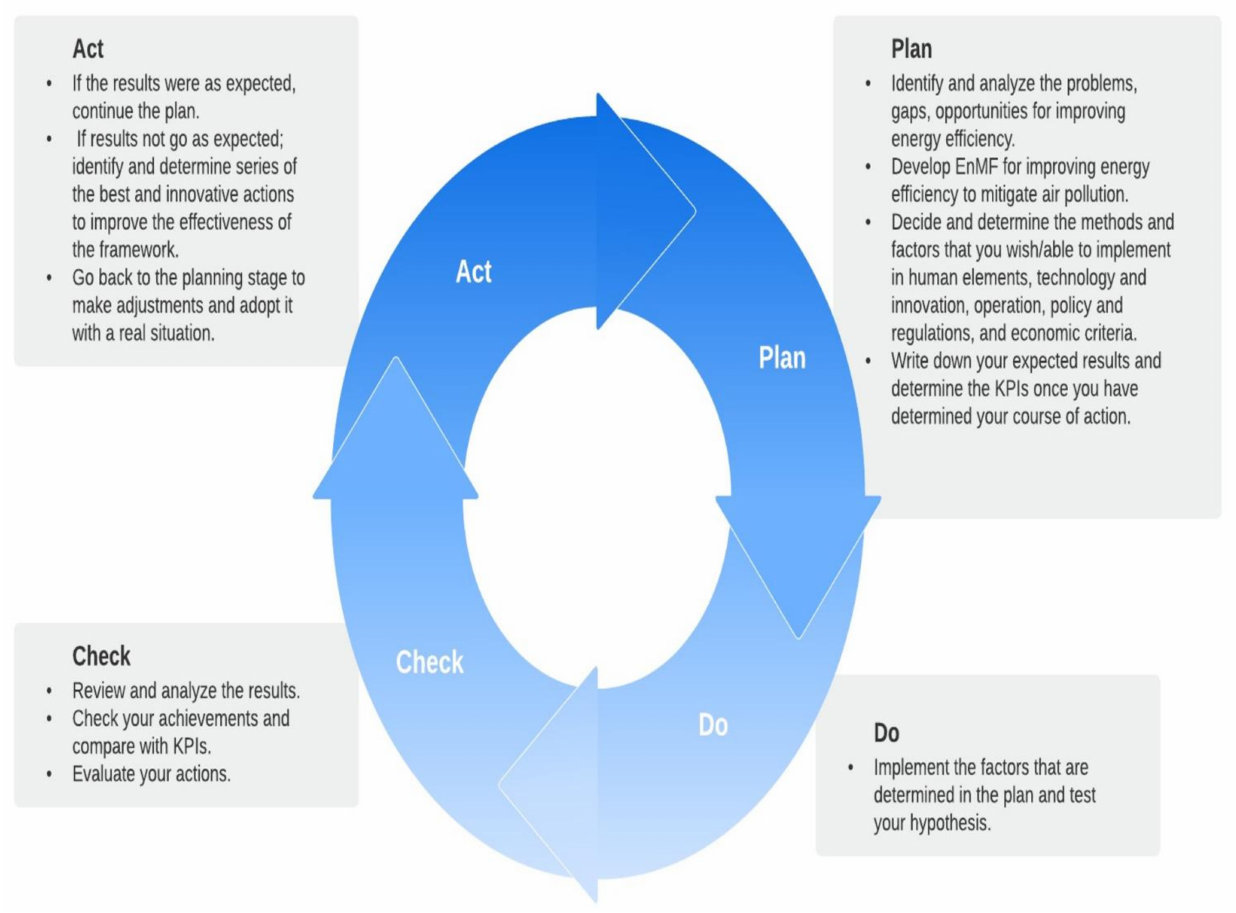
Figure 2. Plan, Do, Check, and Act (PDCA)